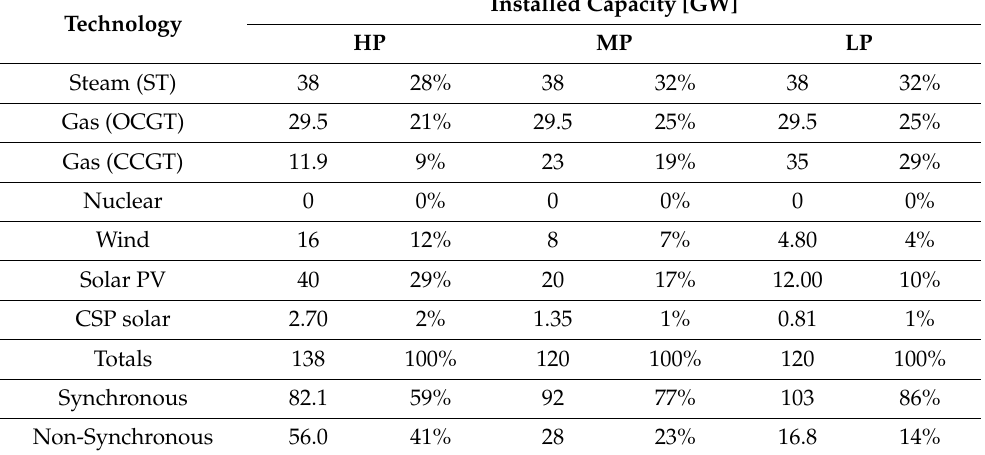
Table 2. Summary of the KSA’s energy mix for